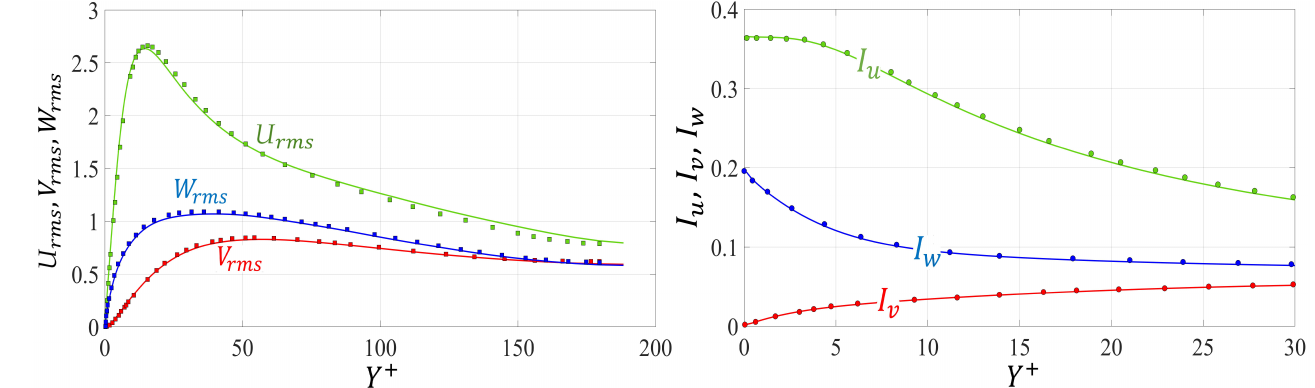
Figure 8. Estimates of the primary fluctuations for the smooth channel case: ( left ) root-mean-squares of the turbulent fluctuations in velocity components; ( right ) turbulence intensities. The reference results of the RMS fluctuations by Vreman and Kuerten [4] (square markers) and the values of the turbulence intensities by Kim et al. [44] (filled circles) are also plotted for comparison.